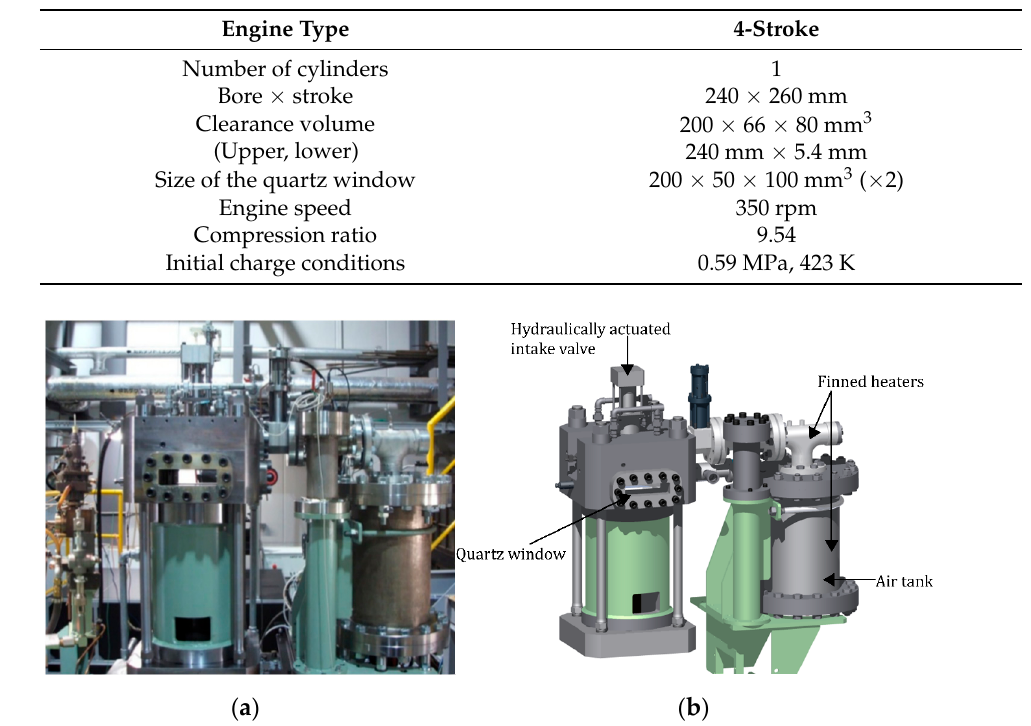
Table 3. RCEM specifications.